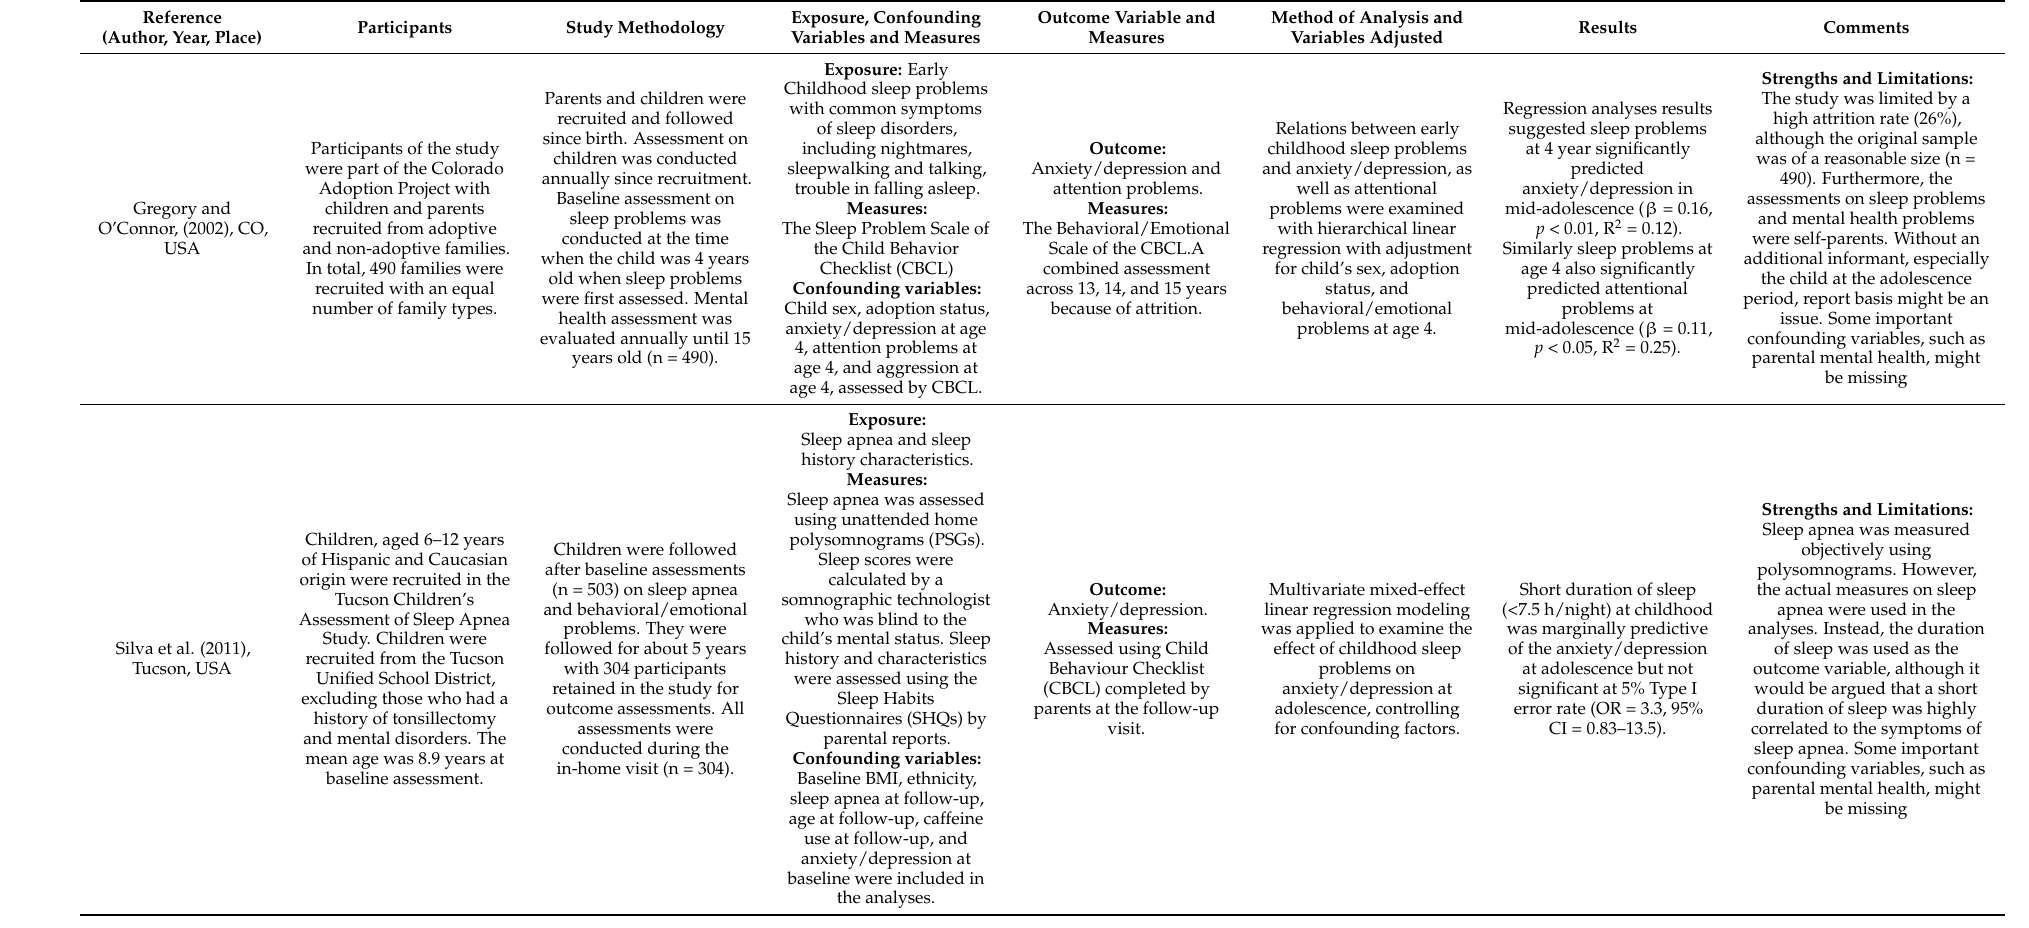
Table 1. Information extracted from the selected studies on early childhood sleep problems and mental health problems in